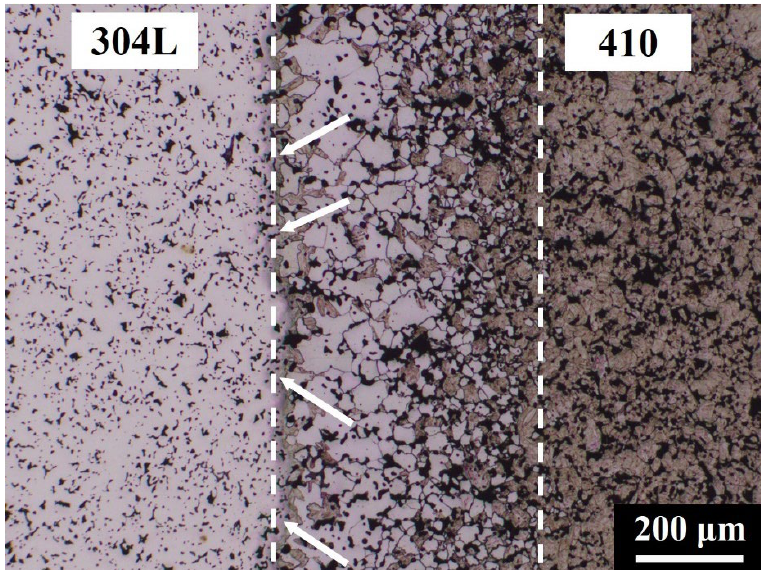
Figure 5. OM microstructure at the interface of the 410/304L LMC.